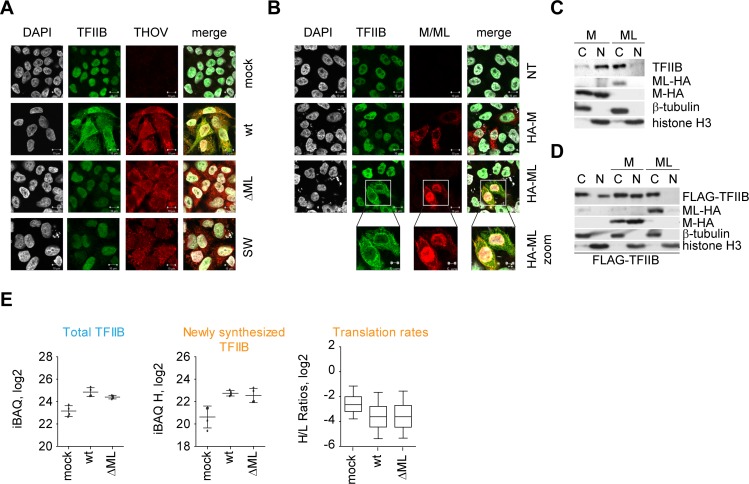
ML sequesters TFIIB from the nucleus, but does not cause its degradation.A) Confocal immunofluorescence analysis of HeLa Kyoto cells stably expressing GFP-TFIIB infected with THOV wt, THOV-ΔML or THOV-SW mutants for 24 hours at MOI 3. HeLa cells were treated as indicated, fixed and stained with GFP-DyLight488, THOV NP+rbAlexa546 and DAPI and subjected to confocal microscopy. Images are representative of two independent experiments with similar results. White bar – 10 μm. B) Confocal immunofluorescence analysis of HeLa Kyoto cells stably expressing GFP-TFIIB and transiently transfected with HA-M or HA-ML for 16 hours. HeLa cells were treated as indicated, fixed and stained with GFP-DyLight488, HA+msAlexa594 and DAPI and subjected to confocal microscopy. Images are representative of four independent experiments with similar results. White bar – 10 μm. C) Cytoplasmic-nuclear fractionation of Vero cells transiently transfected with HA-tagged M or ML for 24 hours. Depicted is endogenous TFIIB. Western blot is a representative of three experiments with similar results. D) Cytoplasmic-nuclear fractionation of Vero cells transiently transfected with FLAG-TFIIB and HA-tagged M or ML for 24 hours. Western blot is a representative of three experiments with similar results. E) Total protein intensity of TFIIB as defined by iBAQ, levels of newly synthesized TFIIB as determined from heavy intensities, and translation rates of identified proteins determined from H (newly synthesized)/L (total) ratios presented as box-whisker plots with whiskers showing 10–90 percentile. Protein levels were estimated in four biological replicates.